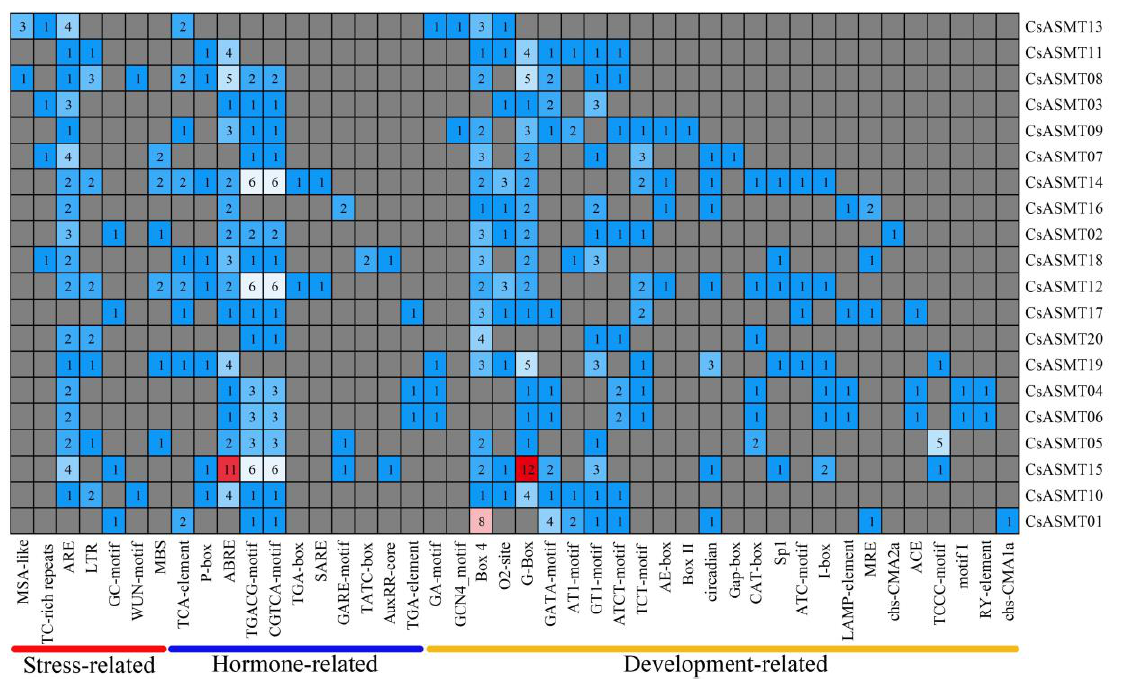
Figure 6. Distribution of the number of cis-acting elements in the C. sinensis ASMT gene promoter.